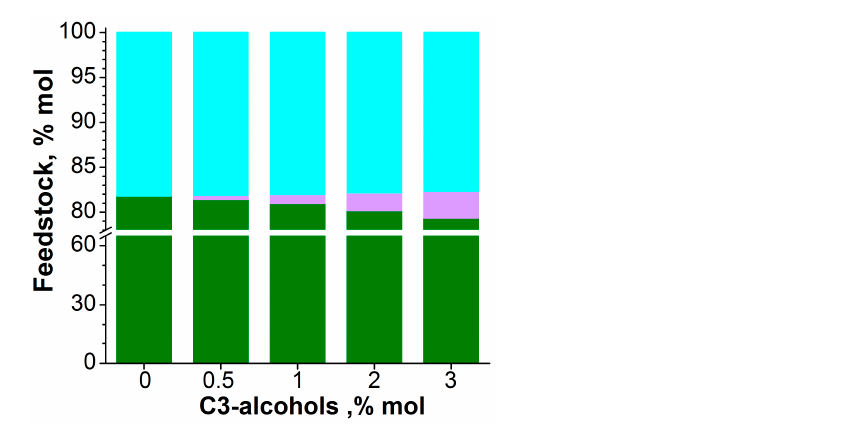
Figure 9. Feedstock composition for MTR plotted against C3 ‐ alcohol concentrations in bioethanol.